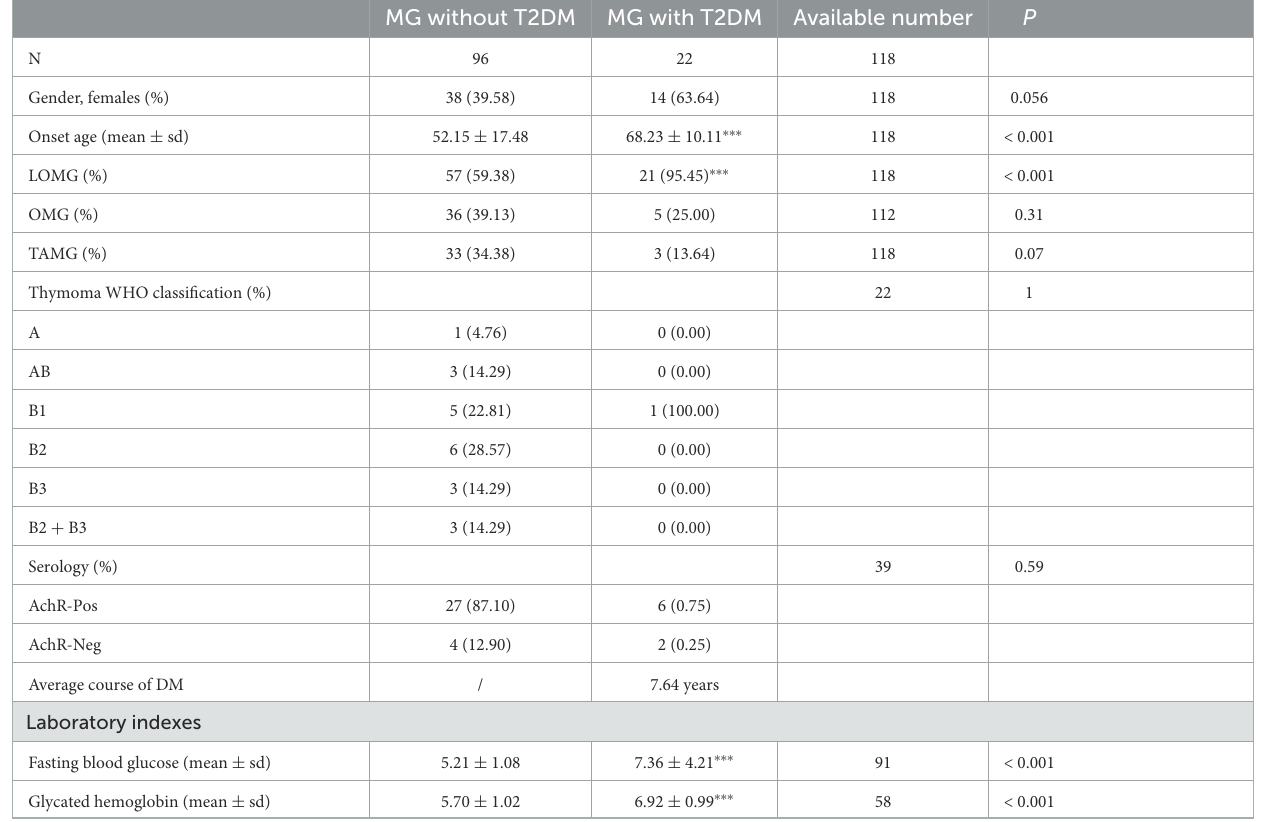
TABLE 5 Different characteristics between non-diabetic and diabetic MG patients. MG without T2DM MG with T2DM Available